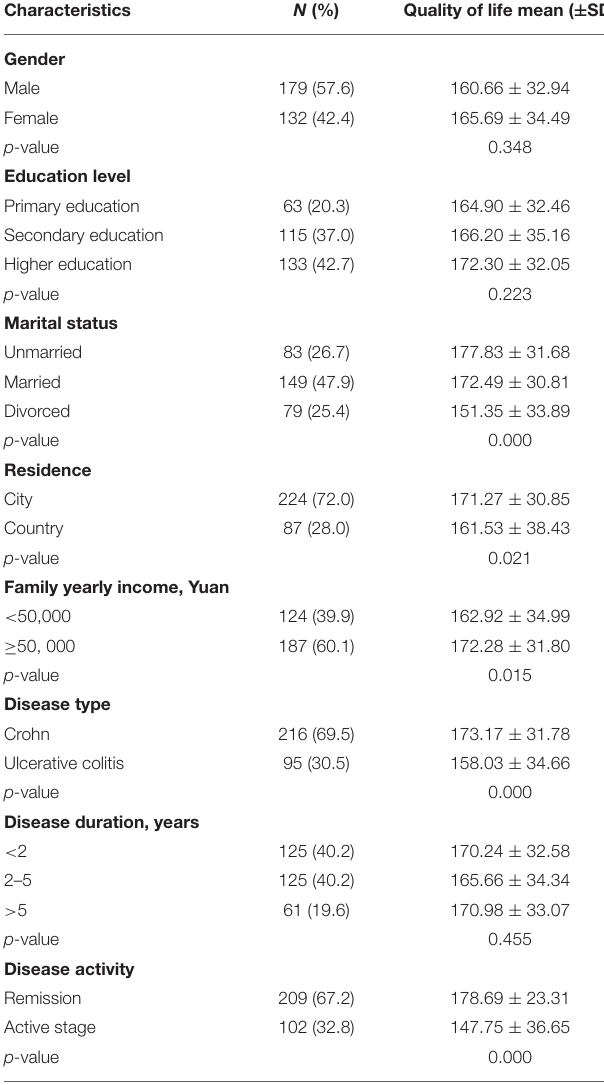
TABLE 1 | Demographic and clinical characteristic differences in scores of quality of life.